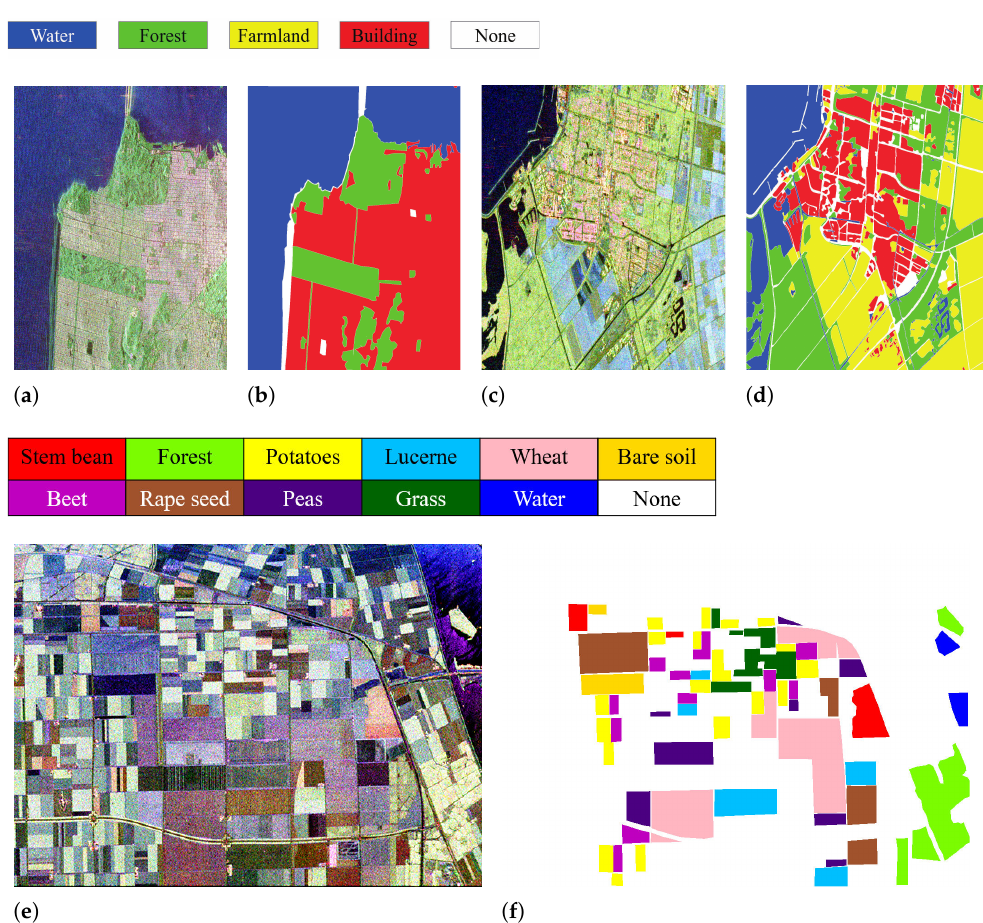
Figure 10. Pauli-based RGB images and manually labeled ground truth maps of the experimental data. ( a , b ) Rs2-Sanf data; ( c , d ) Rs2-Flevoland data; ( e , f ) As-Flevoland